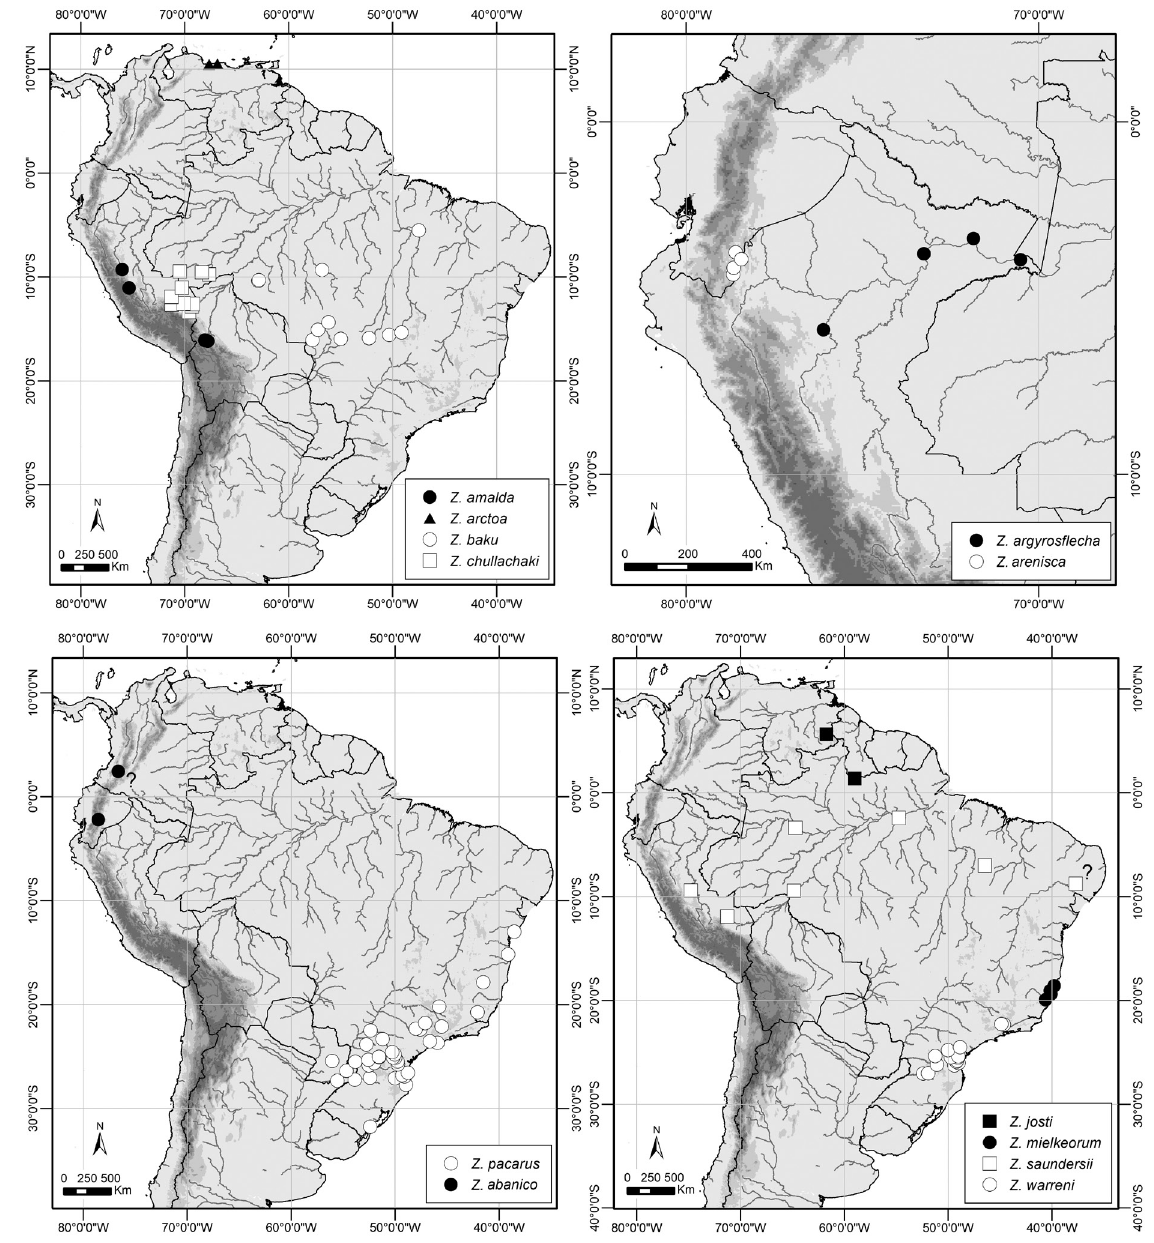
Fig. 14. Distribution maps for taxa of Zischkaia Forster,